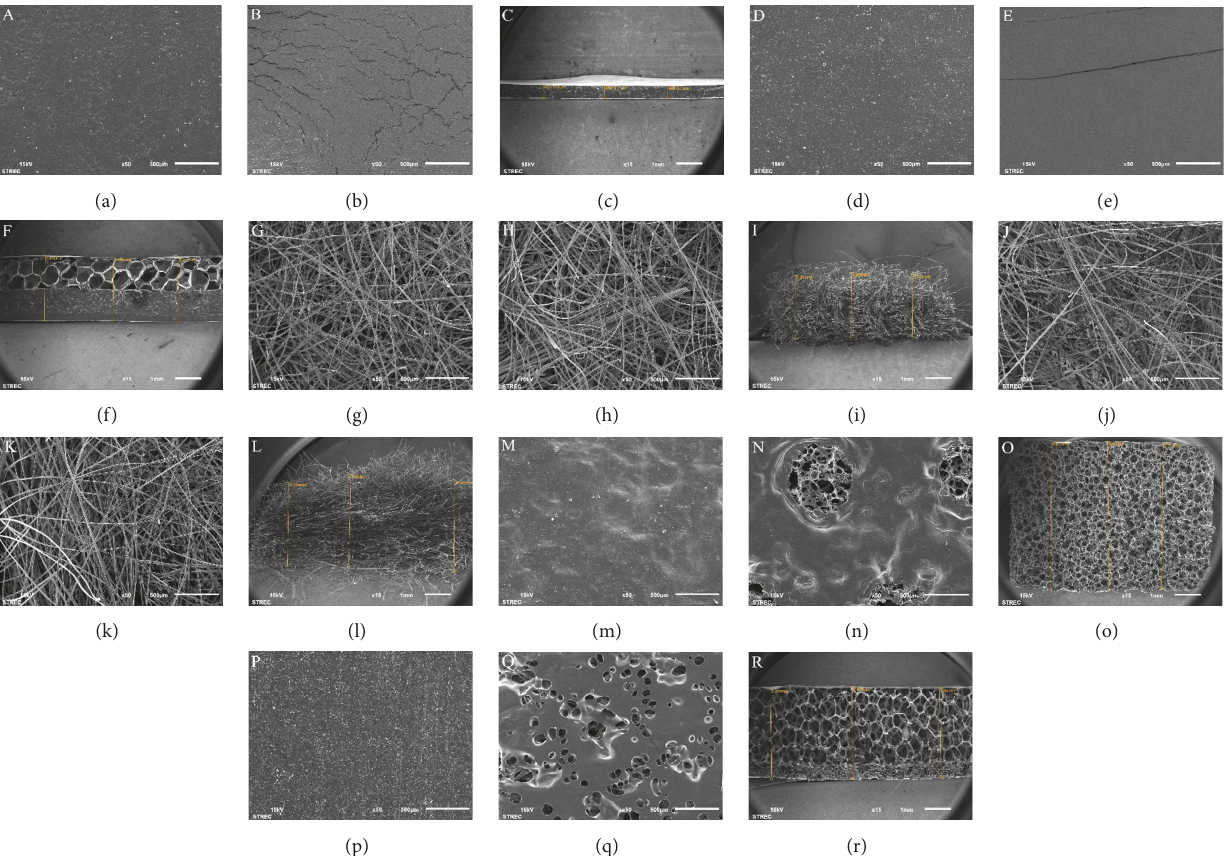
Figure 1: SEM photograph of (a) the upper surface, (b) lower surface, and (c) cross section of a hydrocolloid dressing; (d) the upper surface, (e) lower surface, and (f) cross section of hydrocolloid with a foam layer dressing; (g) the upper surface, (h) lower surface, and (I) cross section of a calcium alginate dressing; (j) the upper surface, (k) lower surface, and (l) cross section of a calcium sodium alginate dressing; (m) the upper surface, (n) lower surface, and (o) cross section of foam with a polyurethane film layer dressing; (p) the upper surface, (q) lower surface, and (r) cross section of foam with a hydrogel and polyurethane film layer dressing.